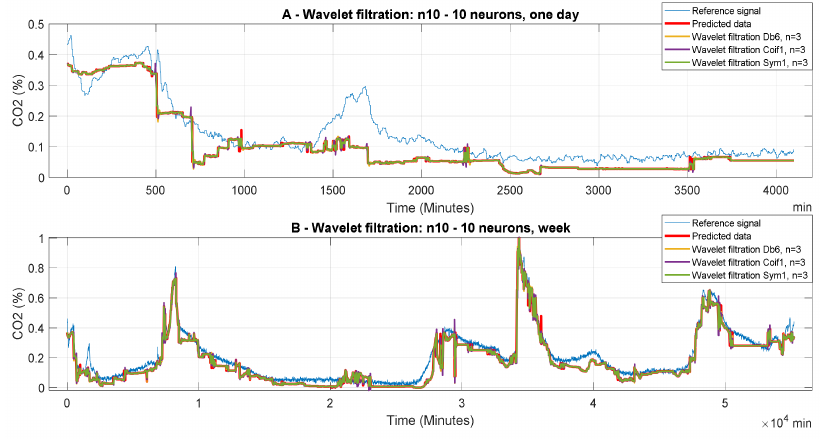
Figure 13. Dependence of CO 2 prediction on the time period for the ANN Model 1.